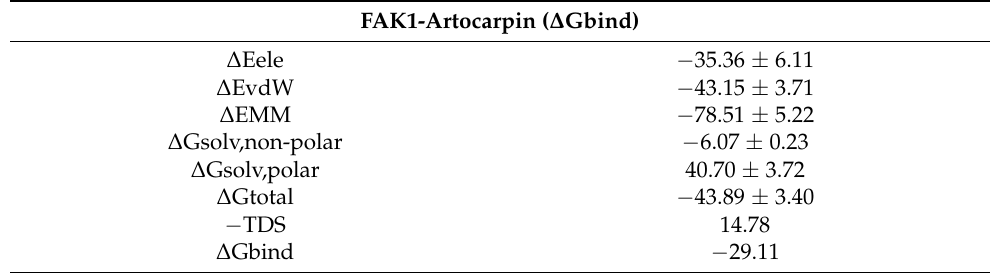
Figure 5. Effect of artocarpin on epithelial to mesenchymal transition (EMT): A549, H460, and BEAS-2B cells were treated with various concentrations of artocarpin (0–10 µ M) for 24 h. ( A – I ) The expression levels of EMT protein markers were investigated by Western blotting, as well as the mRNA expression levels of EMT markers ( C , F ) were obtained by quantitative real-time polymerase chain reaction. Blotting membranes were probed with β -actin to confirm equal loading of samples. ( G – I ) The expression levels of Cdc42, mTOR, FAK and Akt proteins, and their phosphorylated forms, were investigated. ( J – L ) Relative protein levels were quantified using densitometry. β -actin was used as loading control. The data are shown as mean ± SD ( n = 3). * p < 0.05, ** p < 0.01 versus non-treated control. ( M ) Schematic mechanism of artocarpin in suppression of EMT markers and filopodia formation in lung cancer cells. Table 1. The MM/GBSA ( ∆ Gbind ) and its energy components (kcal/mol) of the artocarpin-FAK